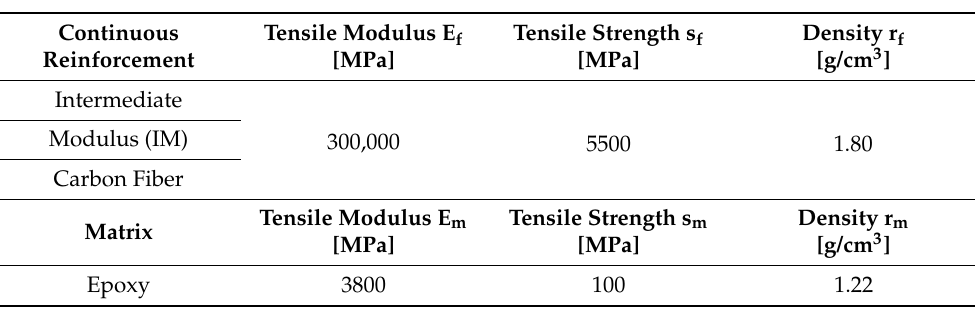
Table 3. Mechanical properties of